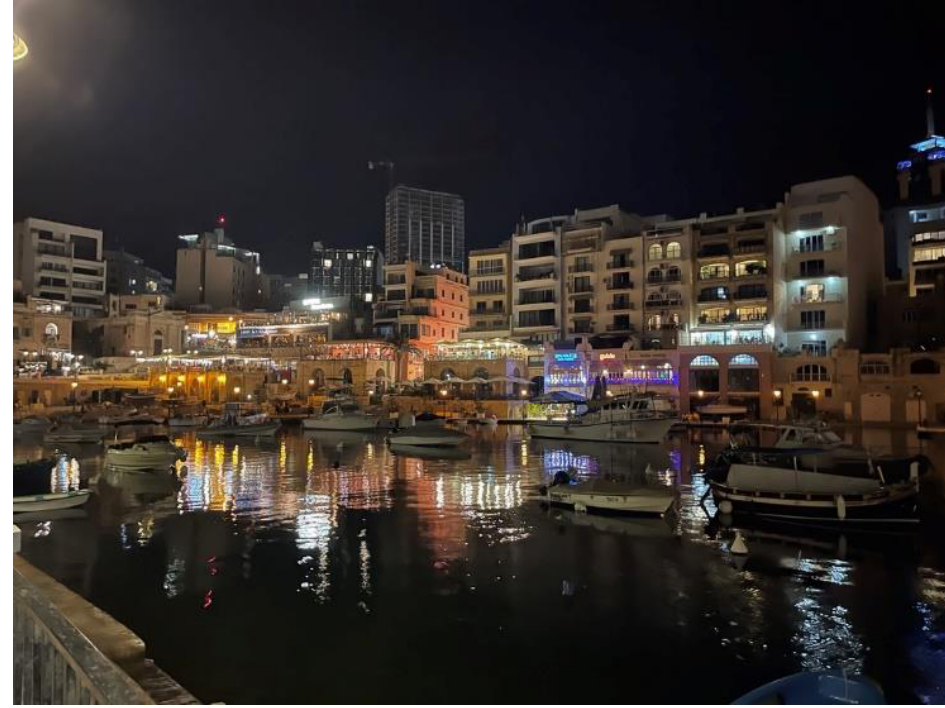
Figure 4. Business operating close to sea level at Spinola Bay, St Julian’s.